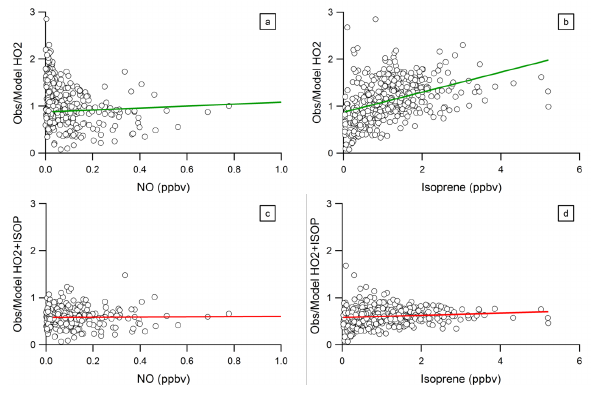
Figure 9: Daytime (6 am-9 pm) measured HO 2 */ modeled HO 2 (top) and measured HO 2 */modeled Fig. 9. Daytime (6 a.m.–9 p.m.) measured HO ∗ / modeled HO 2 (top) HO2+ISOP (bottom), plotted versus NO (left) and isoprene (right) during CABINEX 2009. Unweighted 2 linear correlations are shown in red and green. and measured HO ∗ /modeled HO 2 + ISOP (bottom), plotted versus 2 NO (left) and isoprene (right) during CABINEX 2009. Unweighted linear correlations are shown in red and